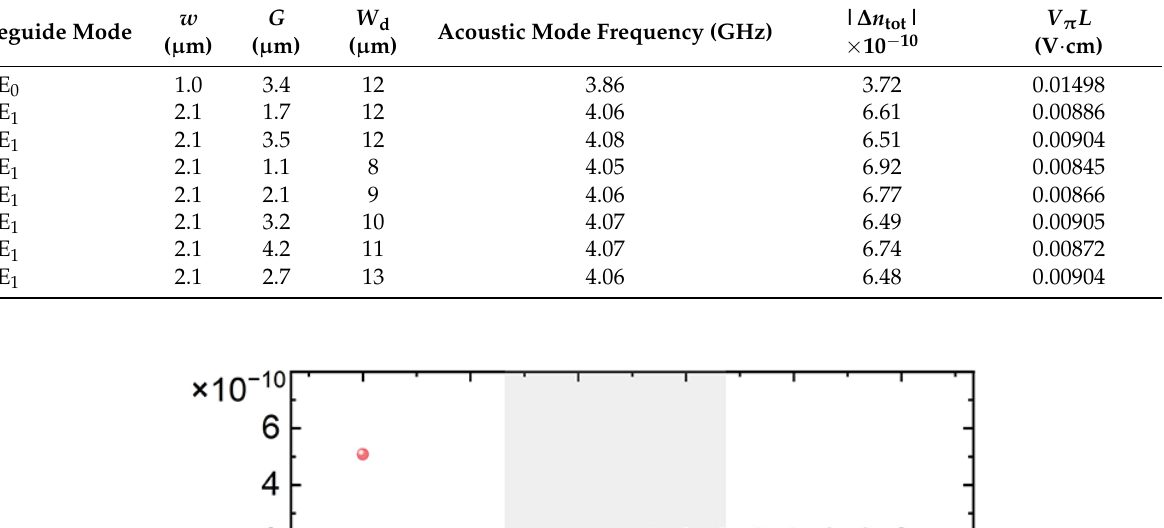
Table 1. Comparison of the AOM effect working at TE 0 and TE 1 mode for different device structures.